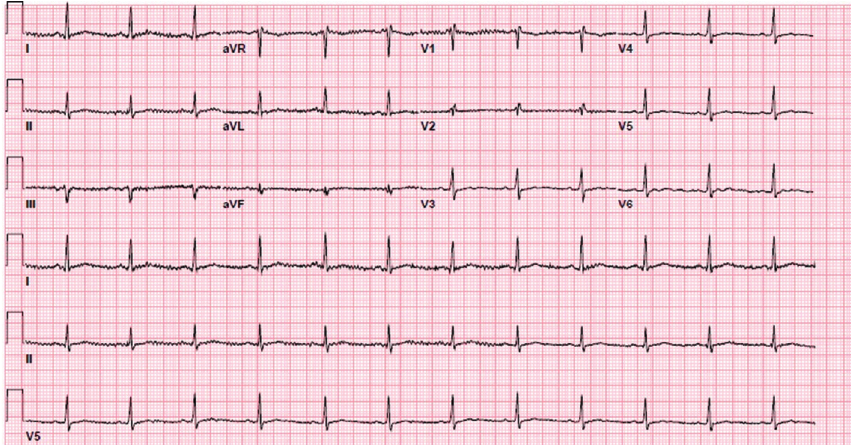
Figure 1: EKG performed in the ED showed a heart rate of 74 and a regular sinus rhythm, with no acute disease processes.